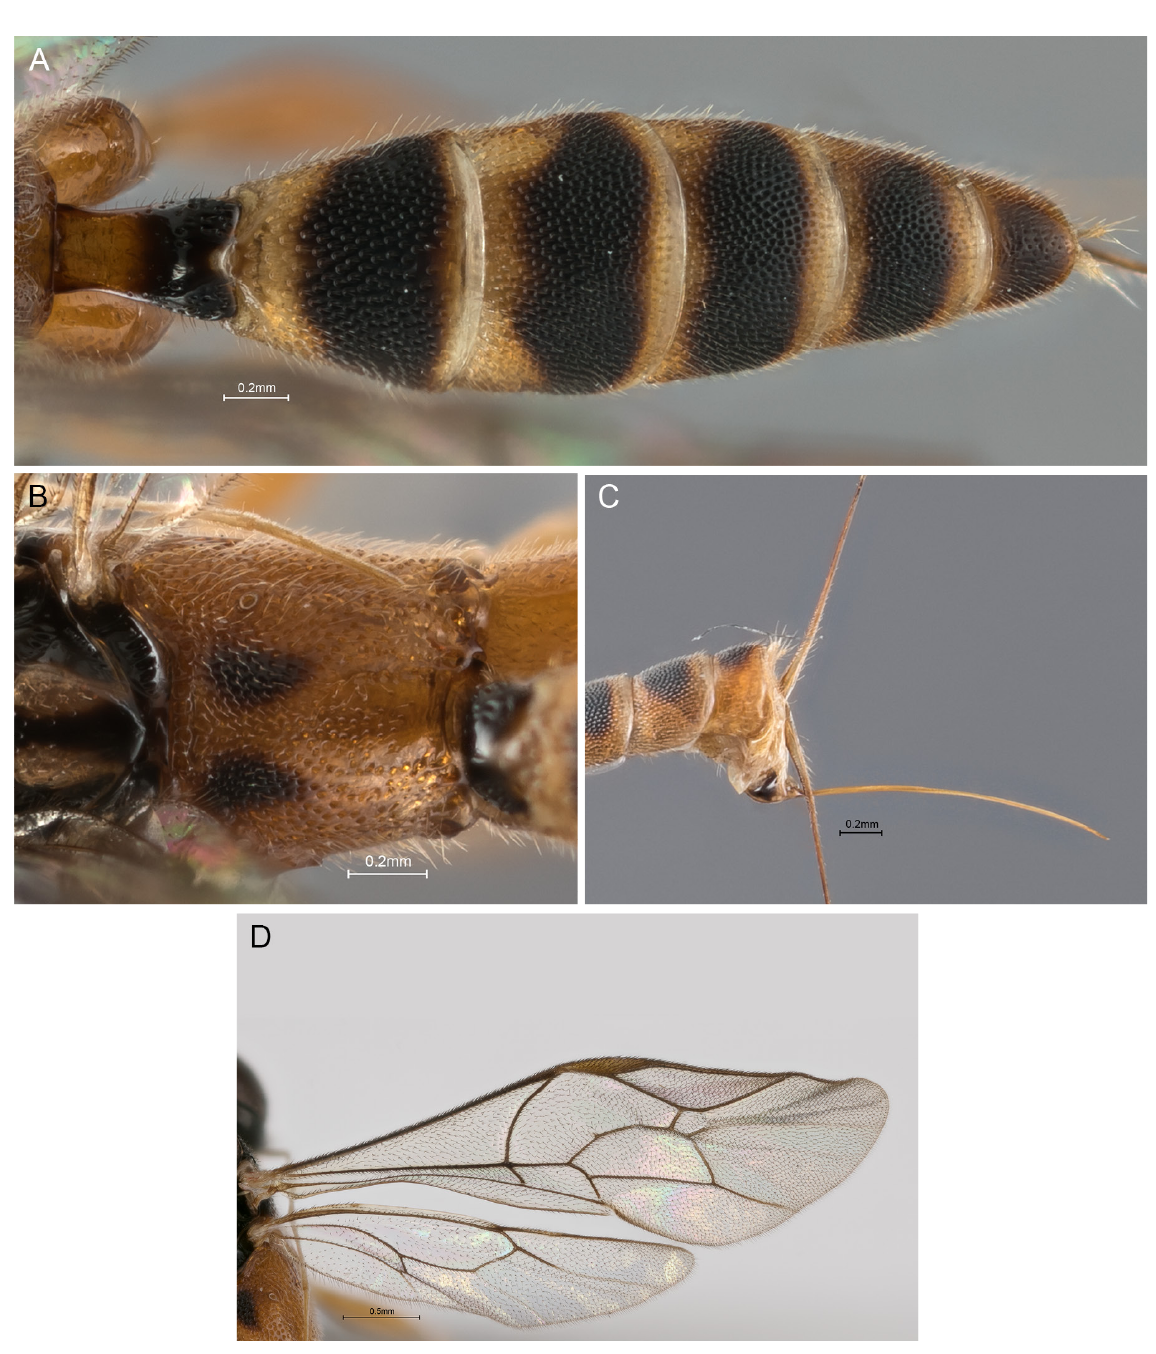
Fig. 18. Palpostilpnus tamasek sp. nov., holotype, ♀ (LKCNHM). A . Metasoma, dorsal view. B . Propodeum, dorsal view. C . Ovipositor. D .